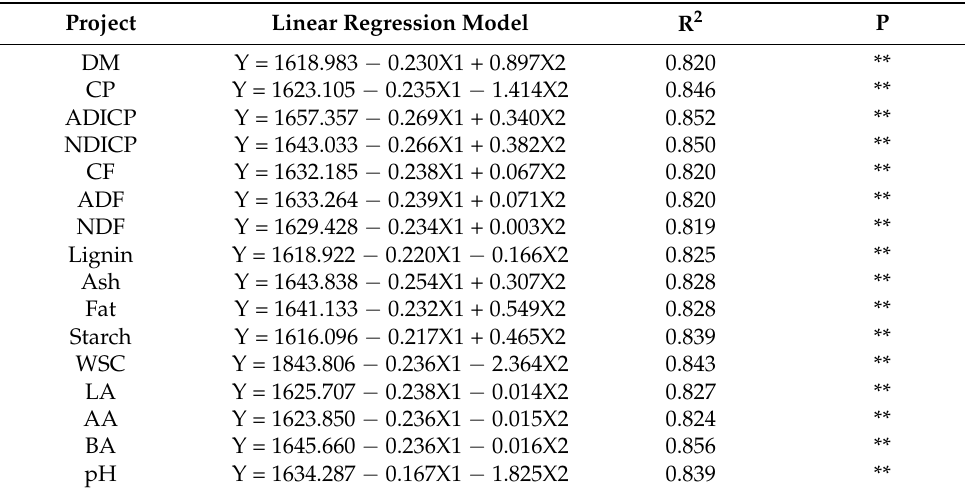
Table 7. Multivariate linear regression analysis between accumulated temperature, compaction density, nutrition and fermentation